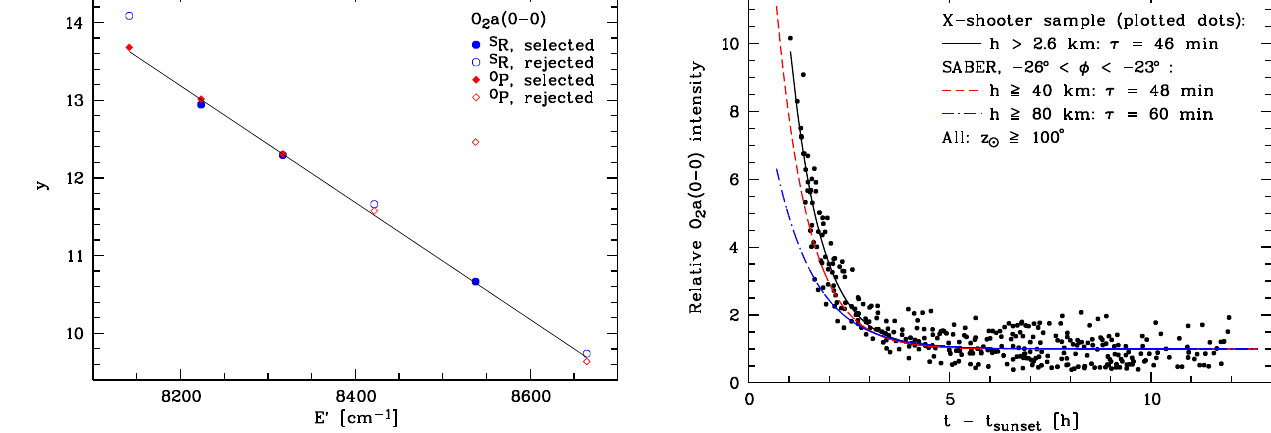
Figure 7. O 2 a (0-0) intensity relative to mean after midnight as a function of the time since sunset for the X-shooter sample (dots). The solid line shows the best fit of a constant and an exponential function to the data. The plot also displays the corresponding fit re- sults for the SABER sample without longitude restriction and lower intensity integration limits of 40 (dashed) and 80km (dash dotted). For the three fits, the resulting radiative lifetimes τ of the daytime population are shown in the